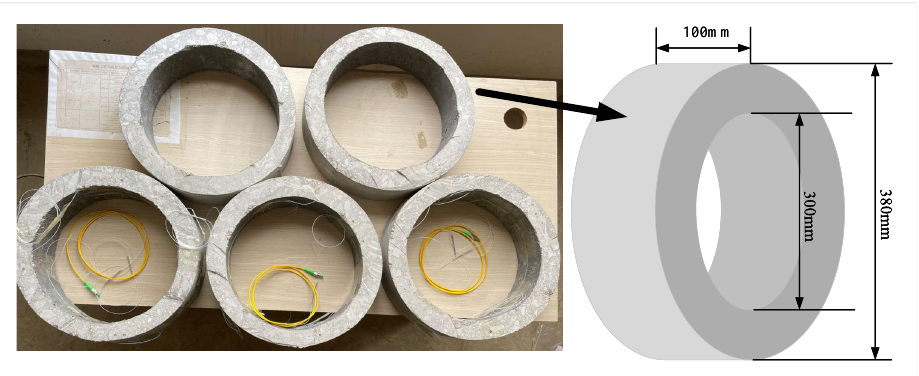
Figure 3. Diagram of concrete specimen.